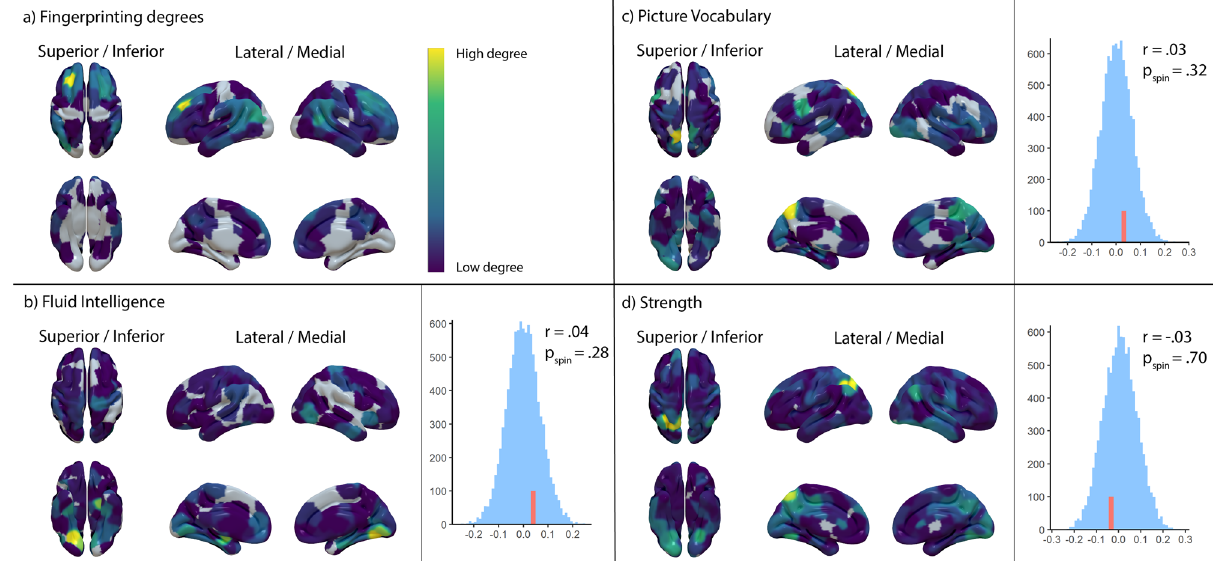
Fig. 3 Spatial distribution of node degrees. Distribution of node degrees for discriminatory nodes a and behaviourally predictive nodes ( b – d ) on the left. The edges underlying the node degrees are thresholded at the 99th percentile and p < 0.01 respectively. The right-hand side displays the spin permutation results, with red lines marking the empirical correlation of discriminatory and predictive